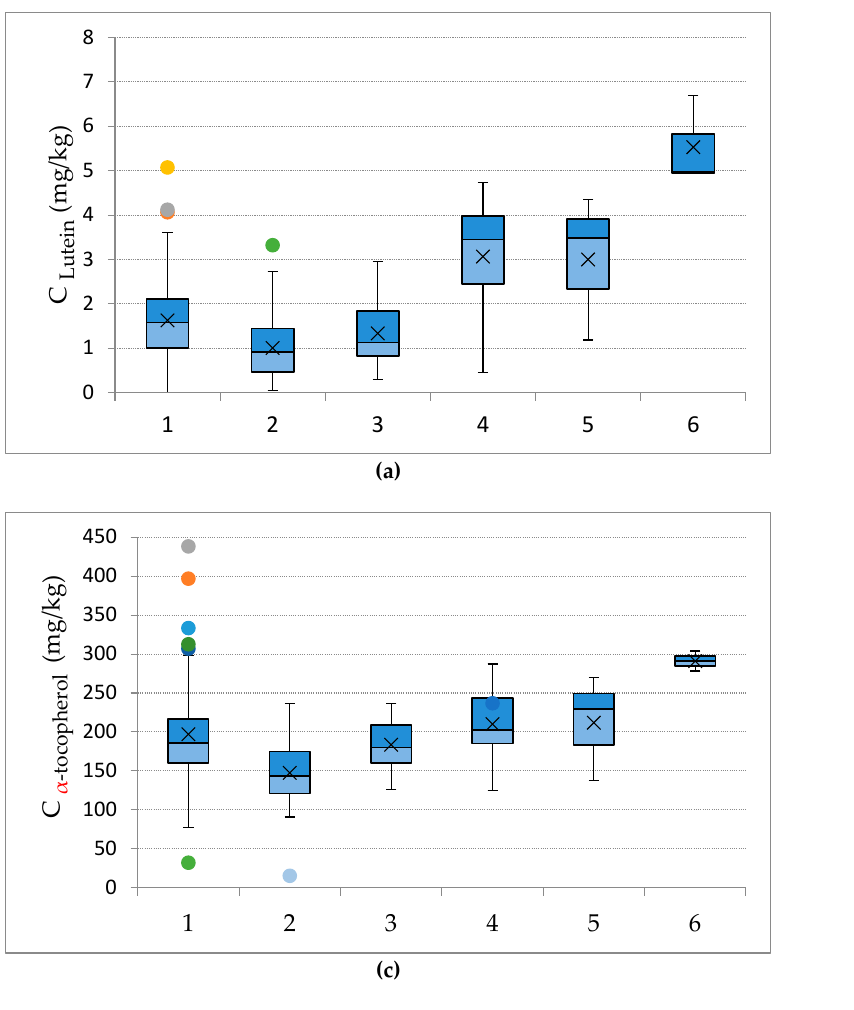
Figure 4. Box-and whisker plots presenting the concentrations of ( a ) lutein, ( b ) squalene, ( c ) α -tocopherol, and ( d ) ( β + γ )-tocopherols in olive oil samples from different varieties. 1—Kolovi 60-100%, 2—Adramitiani 60-100%, 3—Kolovi:Adramitiani 50:50, 4—Koroneiki, 5—Ladoelia, 6- Local Wild Olive Tree.